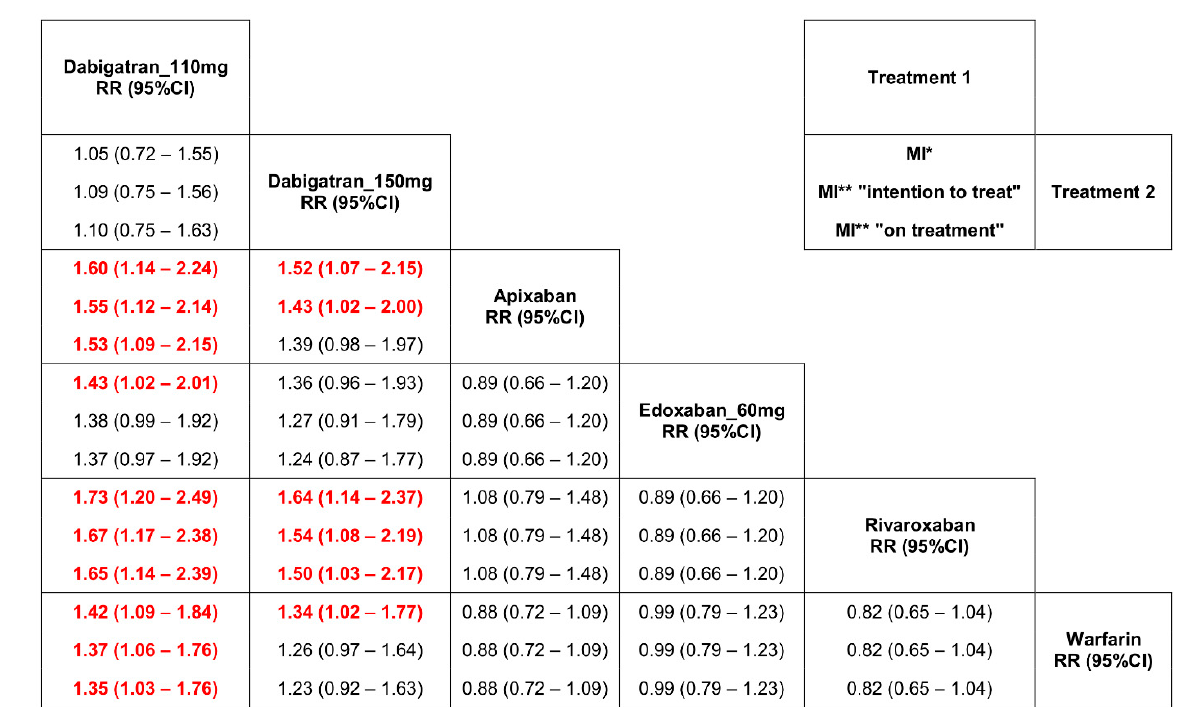
Figure 5. Direct and indirect comparison between warfarin and NOACs for myocardial infarction. * original data from RE-LY study [23], ** results from reanalysis RE-LY study [27]. The red colour shows significant differences.